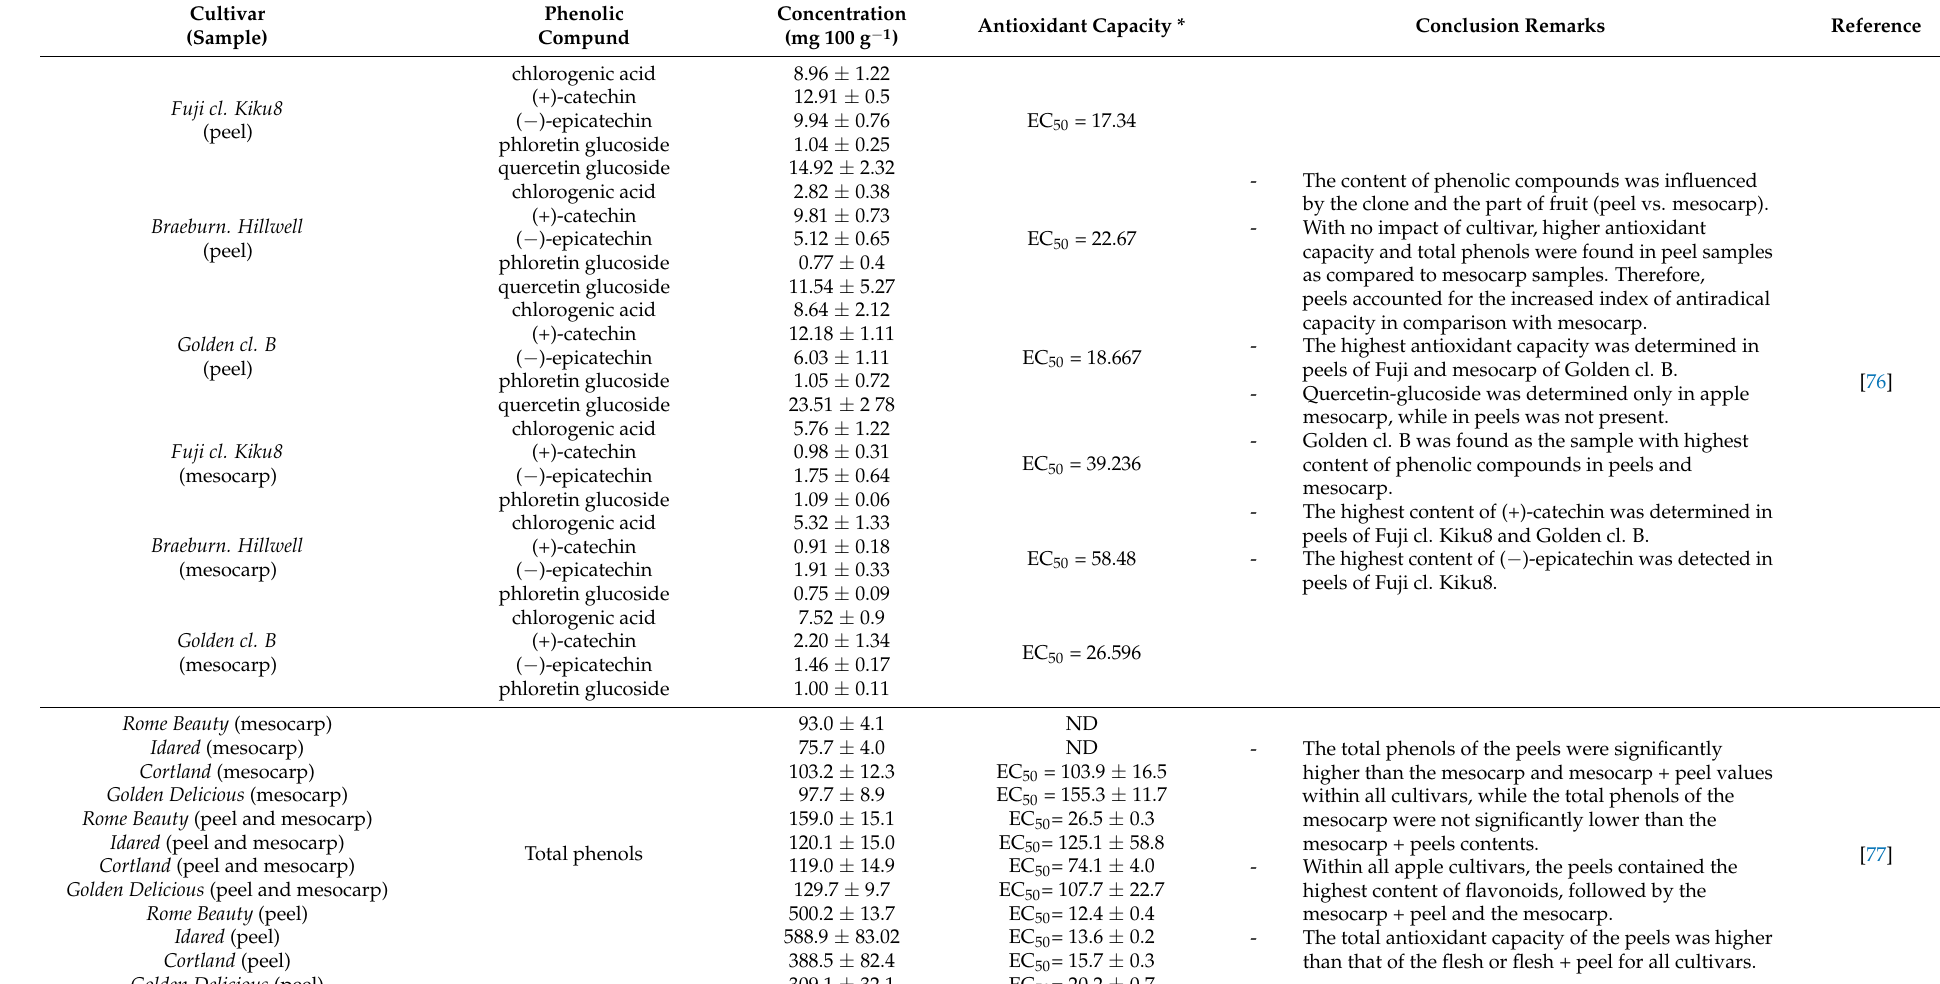
Table 2. The phenolic profile and antioxidant capacity for different parts of the apple in different